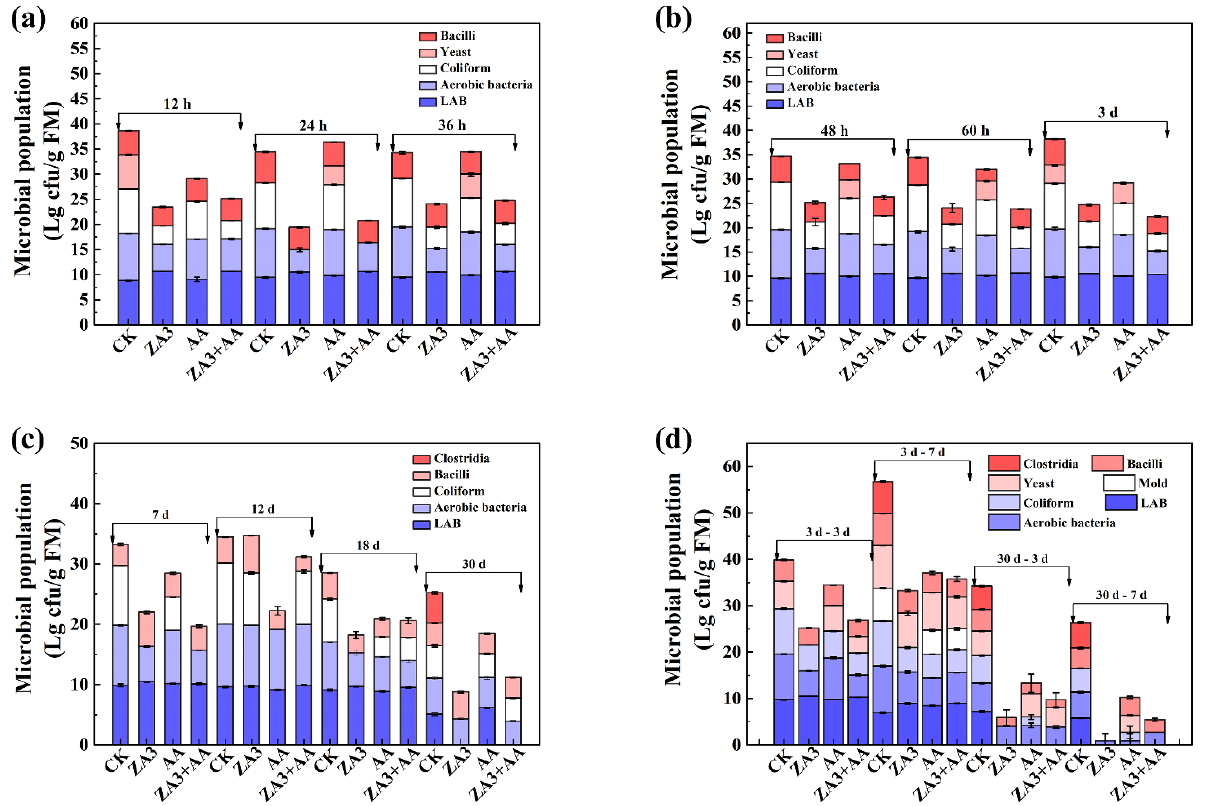
Figure 4. Microbial population of FSBM during fermentation and aerobic exposure. ( a ), fermented for 12, 24 and 36 h; ( b ) fermented for 48, 60 and 72 h; ( c ) fermented for 7, 12, 18 and 30 d; ( d ) aerobic exposure for 3 d – 3 d, 3 d – 7 d, 30 d – 3 d and 30 d – 7 d. cfu, colony forming unit; FM, fresh material; h, hours; d,